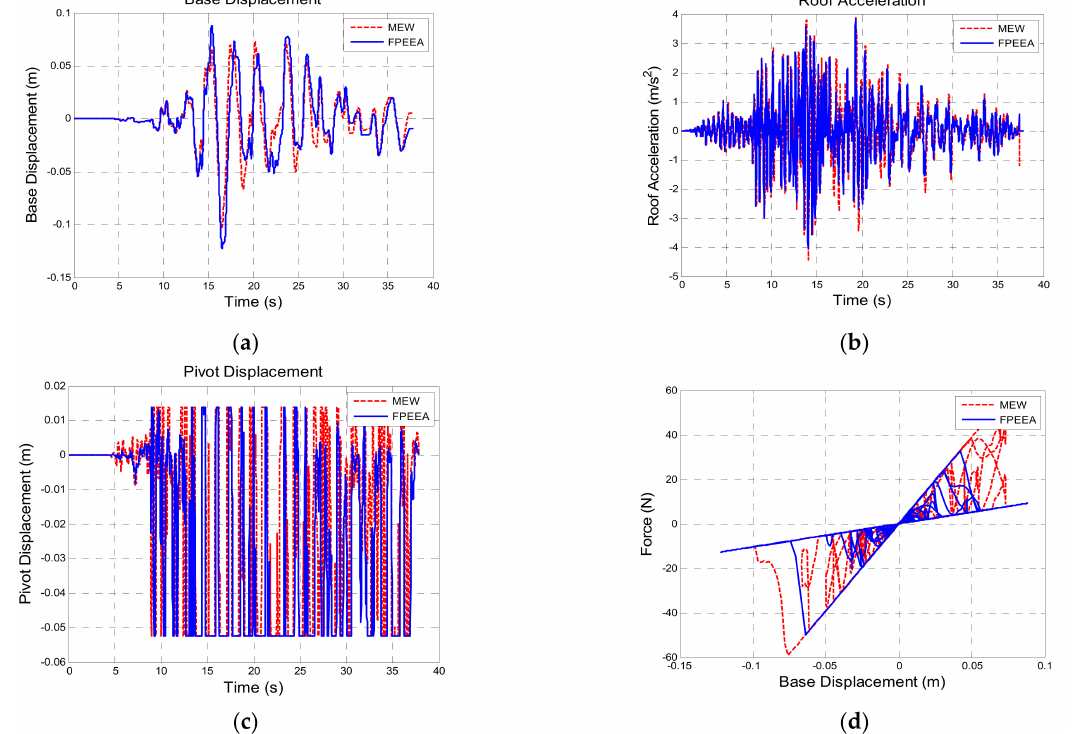
Figure 10. Comparison for the FPEEA and MEW controls (Northridge, PGA = 0.3 g). ( a ) Isolation layer displacement. ( b ) Superstructure acceleration. ( c ) Pivot displacement. ( d ) Hysteresis